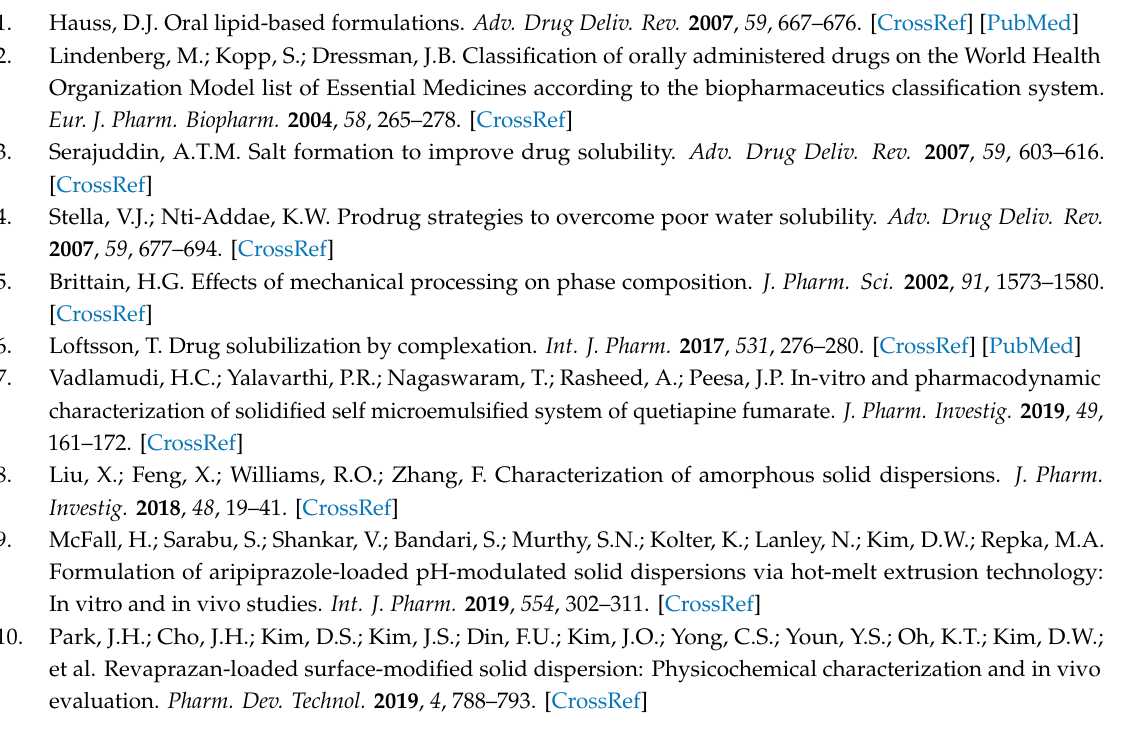
Figure S1: Plasma concentration (log scale)–time profiles of ATO after oral administration of free drug or solid dispersions in